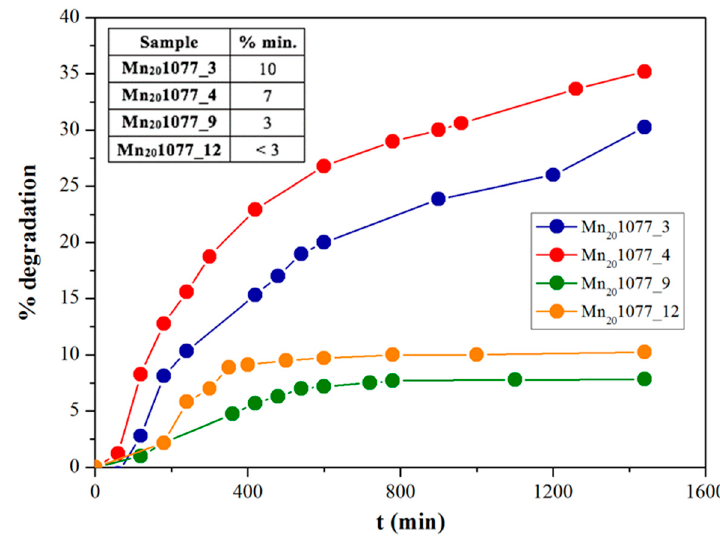
Figure 2. Ethanol degradation percentages after 24 h of Light Emitting Diode(LED) photocatalysis, by different pH Mn-impregnated TiO 2 samples. Table in inset: Relative mineralization degrees.